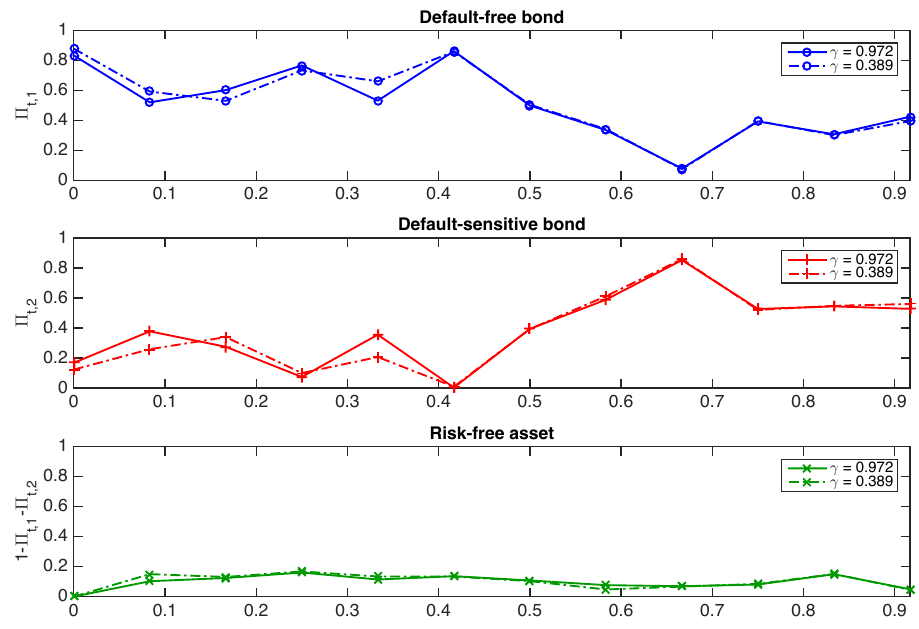
Figure A4. Sensitivity of optimal strategies to a change in γ 1